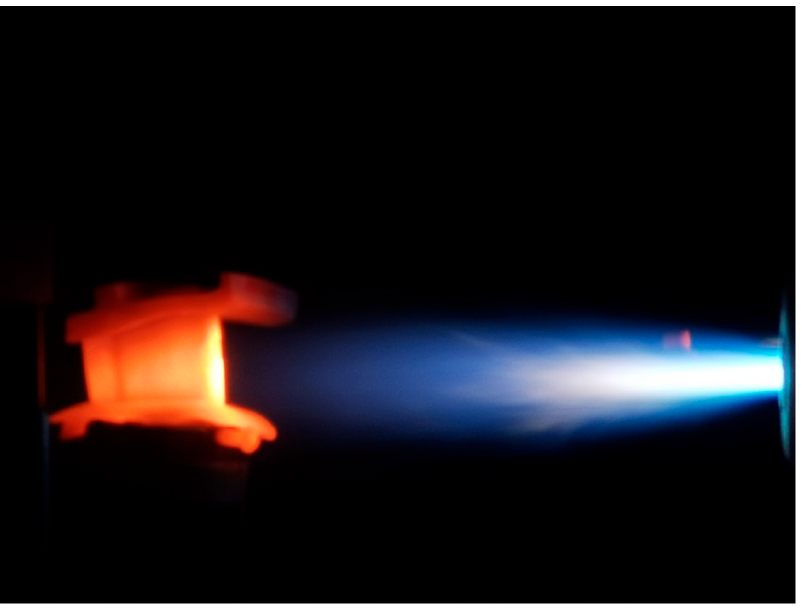
Figure 4. Thermal shock experiment for the SiC/SiC turbine twin guide vanes.